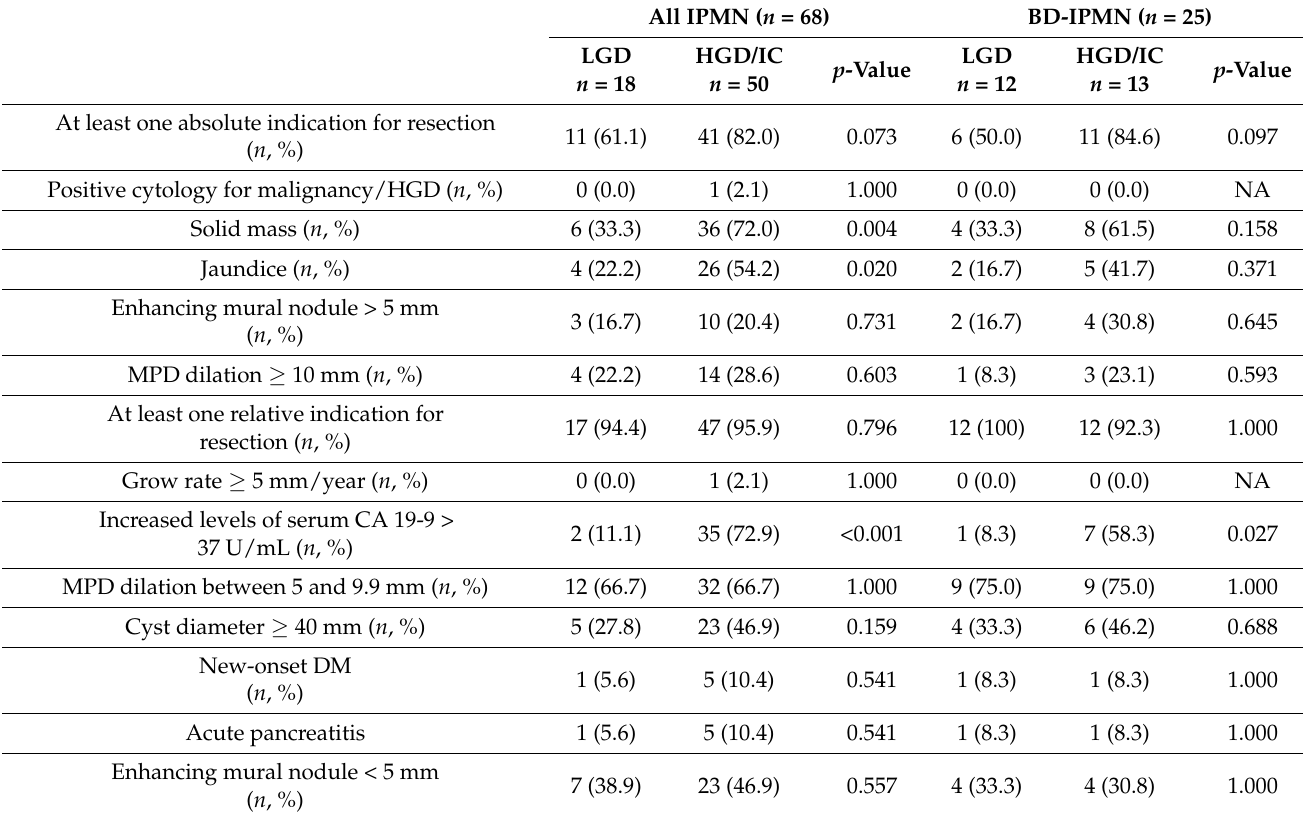
Table 3. Indications for resection according to the evidence-based guidelines on pancreatic cystic neoplasms